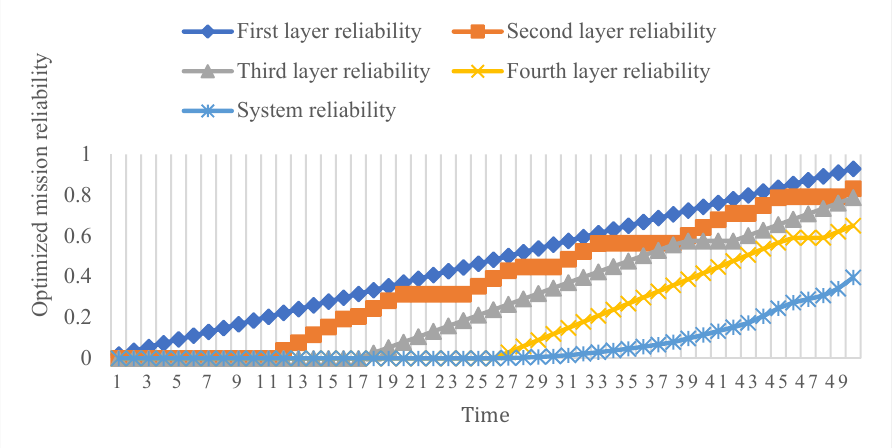
Figure 6. Optimized reliability after redundancy.